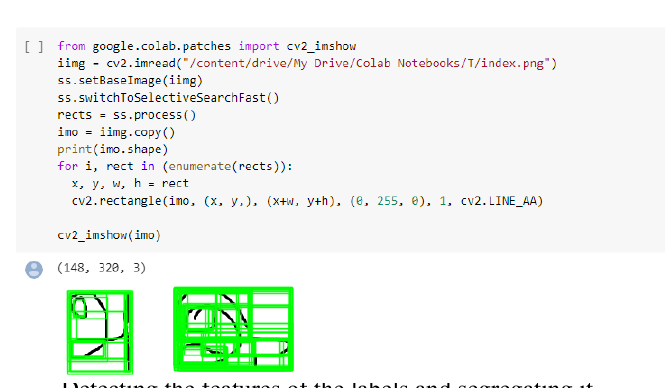
Detecting the features of the labels and segregating